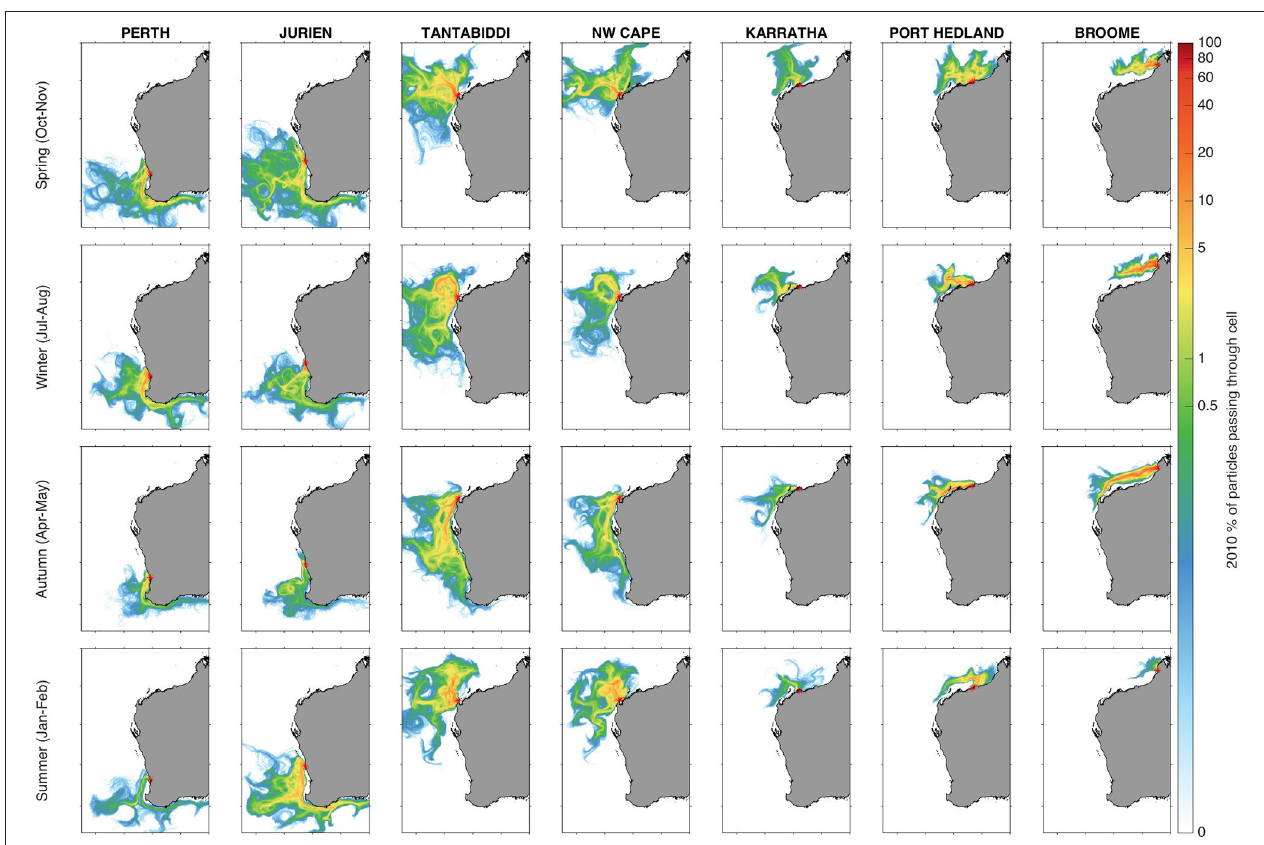
FIGURE 3 | 2010 Seasonal averaged drift trajectories for all seven sites indicating percent of particles passing through each grid cell (seasonal averages of particles released for one month and drifting for 2 months). Red asterisk indicates release location and the color bar is scaled logarithmically to show relevant gradients.